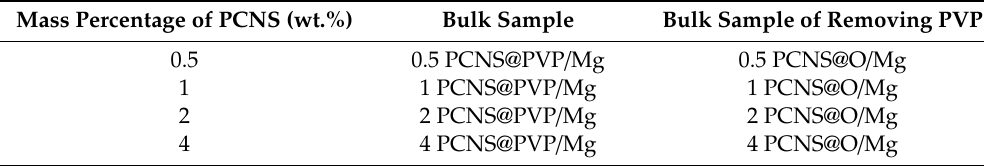
Table 2. Tags of PCNS / Mg composite samples with PVP pretreatment. Mass Percentage of PCNS (wt.%)